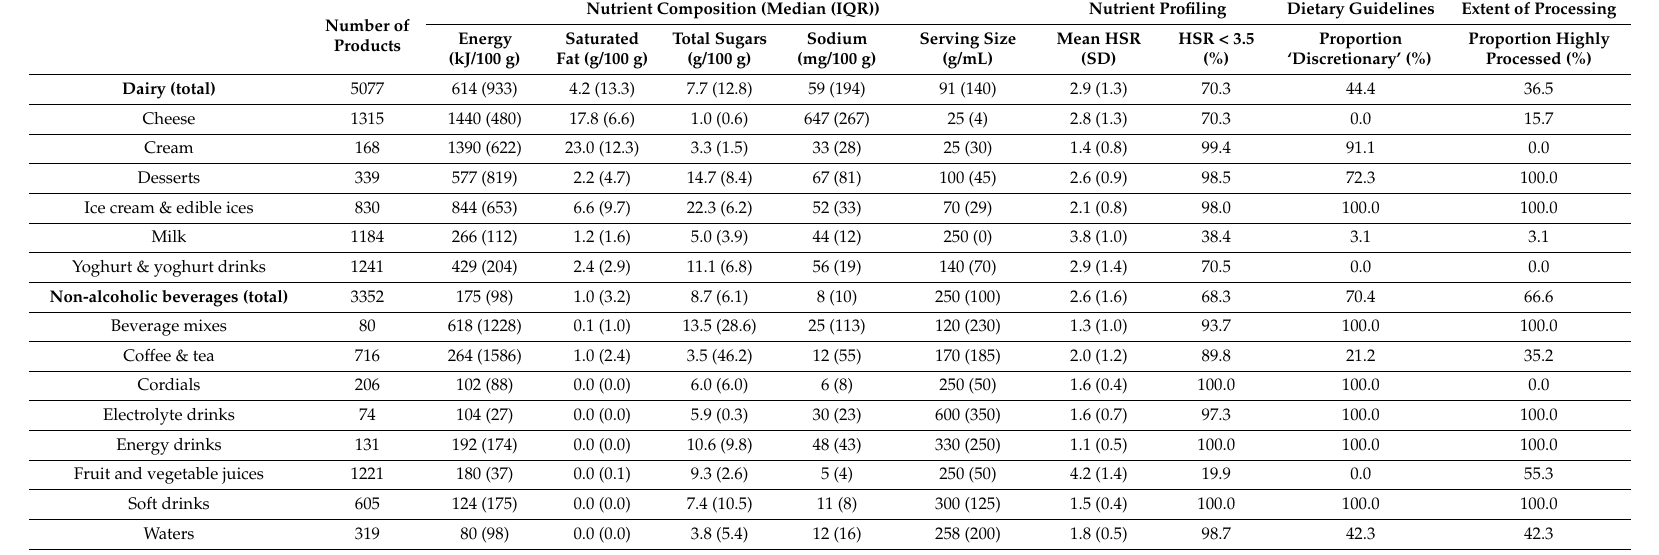
Table 3. Sub-category nutritional assessment analysis for dairy and non-alcoholic beverages categories using multiple measures *. Number of